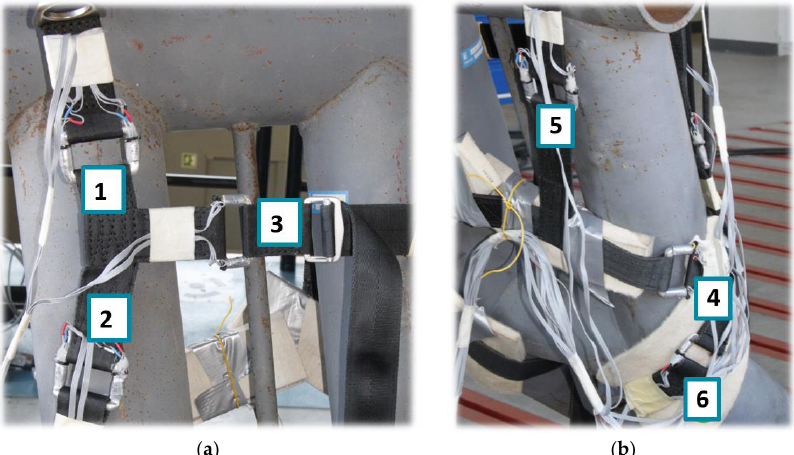
Figure 6. Alignment of measuring elements: ( a ) Front side view of the dummy. ( b ) Back side view of the dummy.